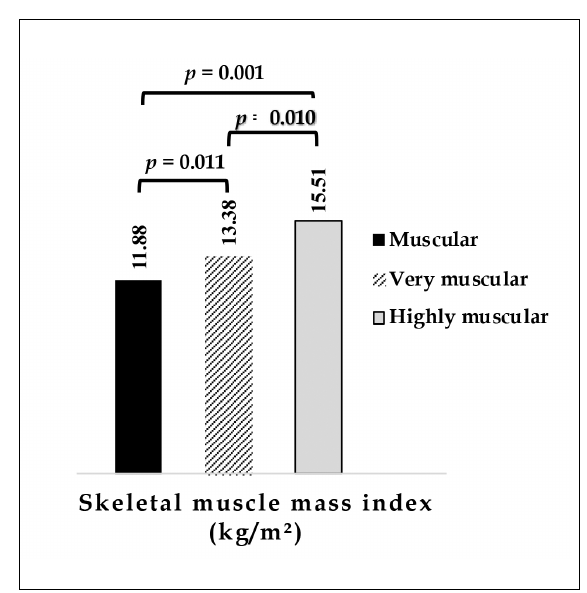
Figure 3. Differences in SMMI between the BMI groups